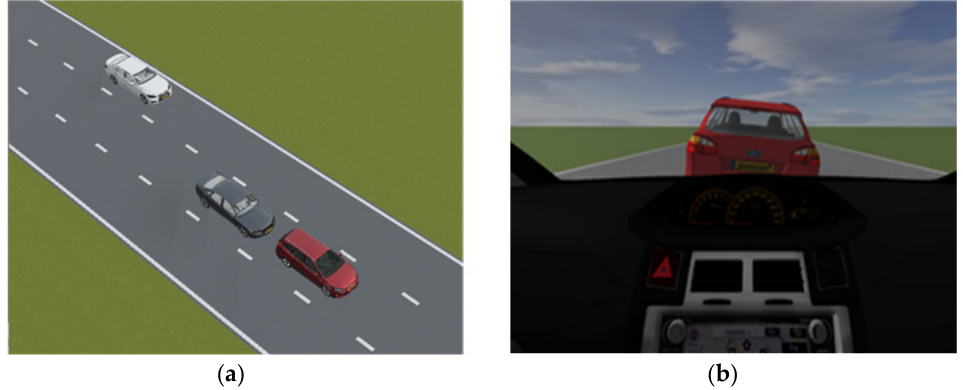
Figure 13. Rear-end conflict in the simulation environment from ( a ) top-view and ( b ) from driver’s view.